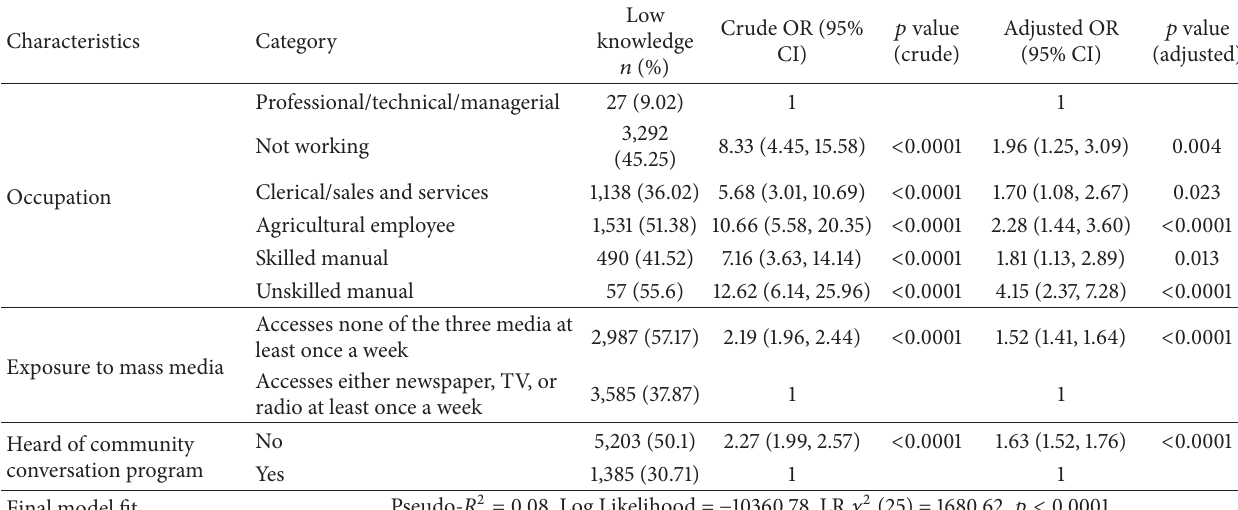
Table 5: Factors associated with low TB knowledge among women, Ethiopia 2011,